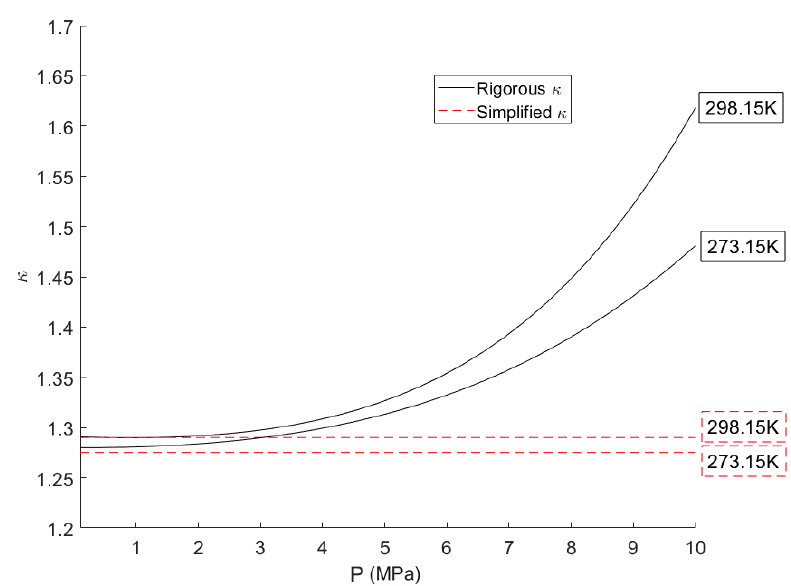
Figure 3. Comparison of the rigorously calculated isentropic exponent with a common simplification for natural gas with a composition of: 85%methane, 14% ethane, and 1%